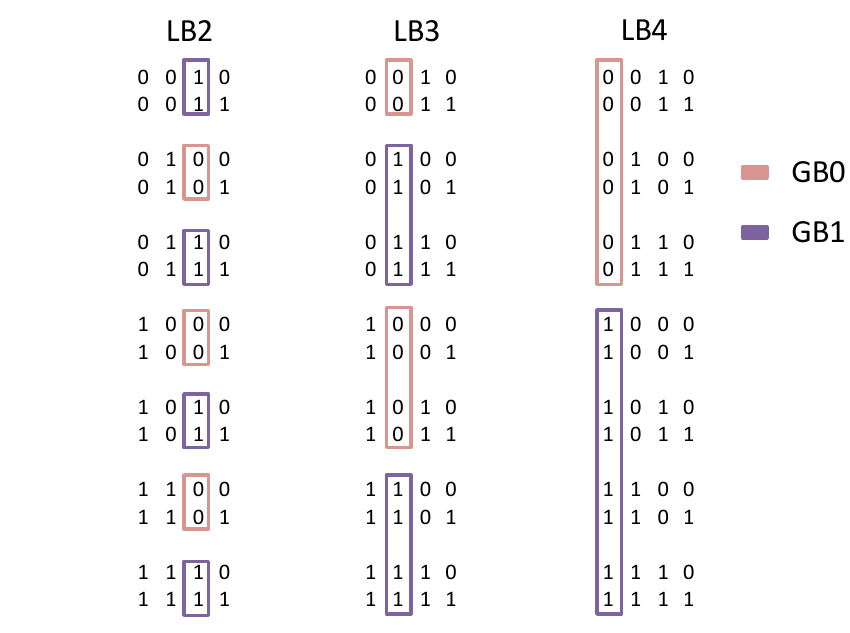
Figure 4. Sample